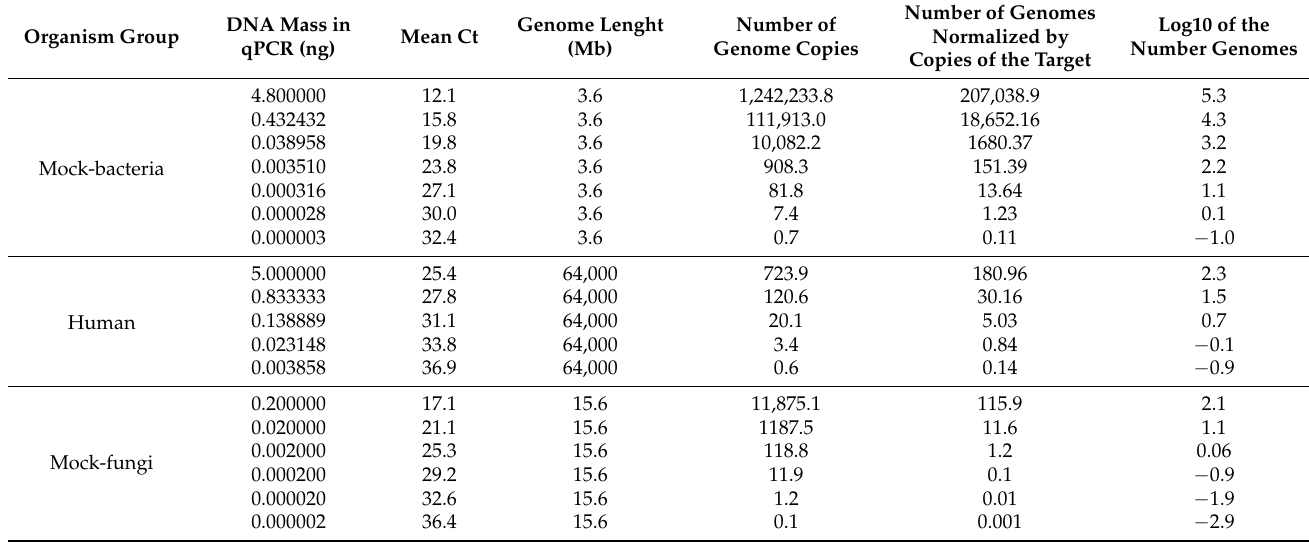
Table 1. Calculated correlations between DNA mass, mean Cts and number of copies of the genomes and the target genes for the mock DNA and human